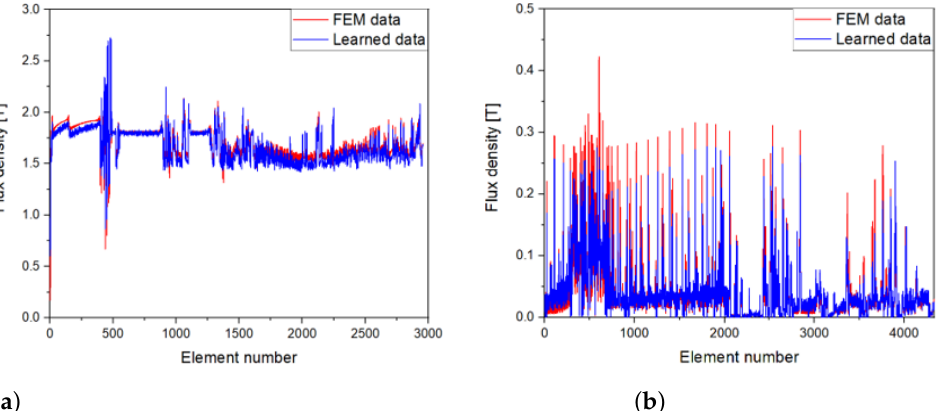
Figure 17. Comparison of harmonics by the FEM and learning model for the modified model: ( a ) stator. ( b ) rotor.